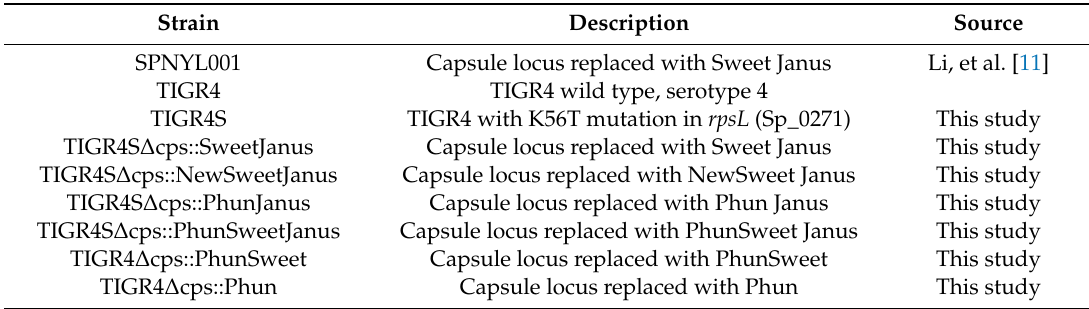
Table 1. Strains used in this